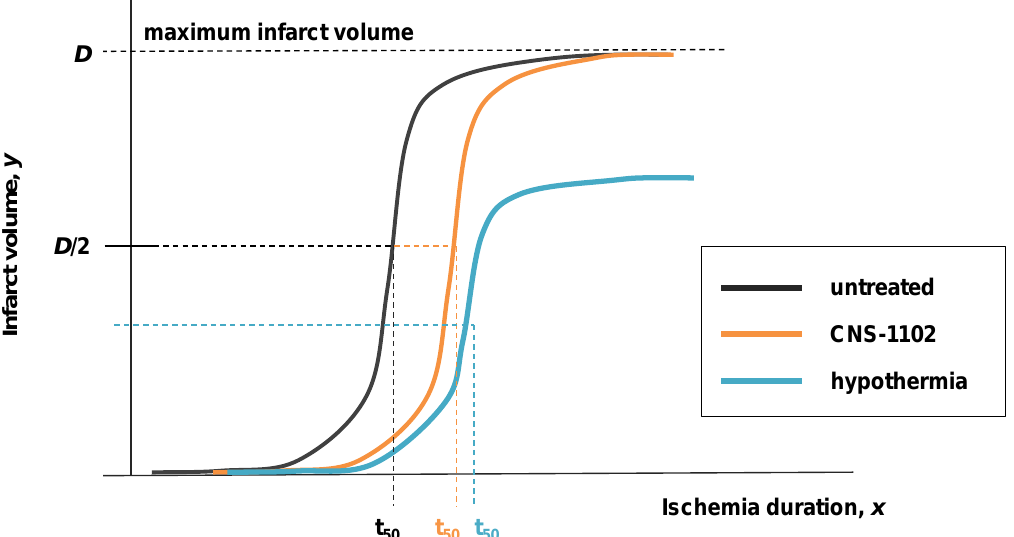
Figure 12. Schematic reproduction of data in Aronowski et al. (1994) [53]. Axes as indicated, and color-coded curves as indicated and explained in the